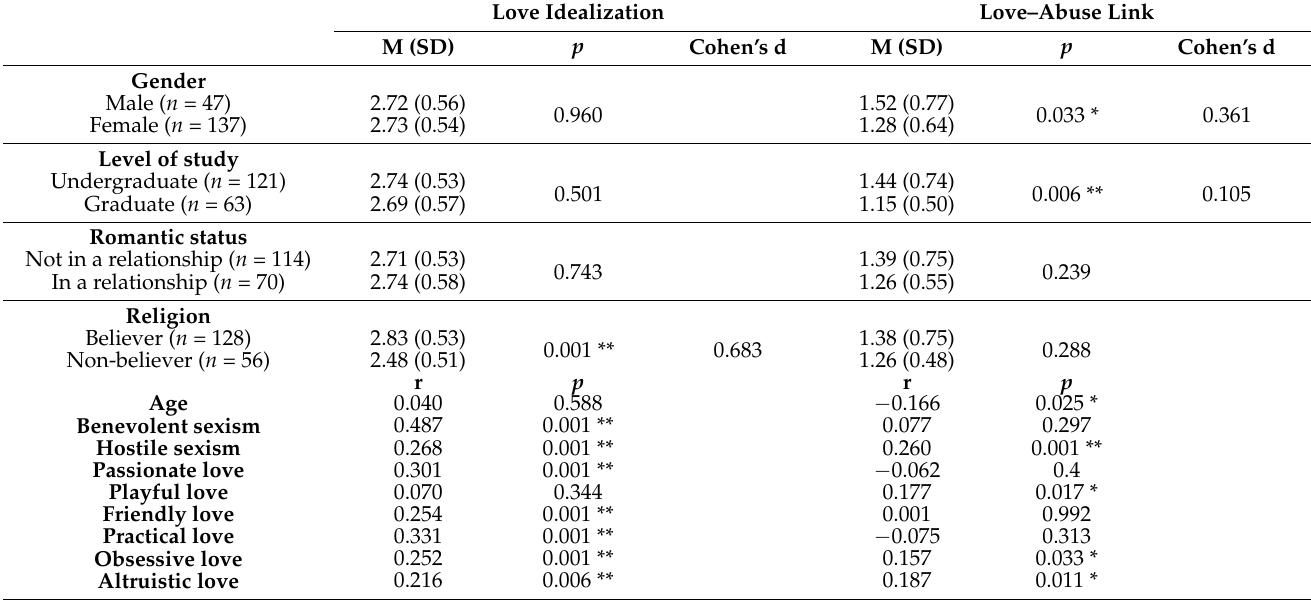
Table 3. Bivariate analysis for dimensions of the romantic love myths